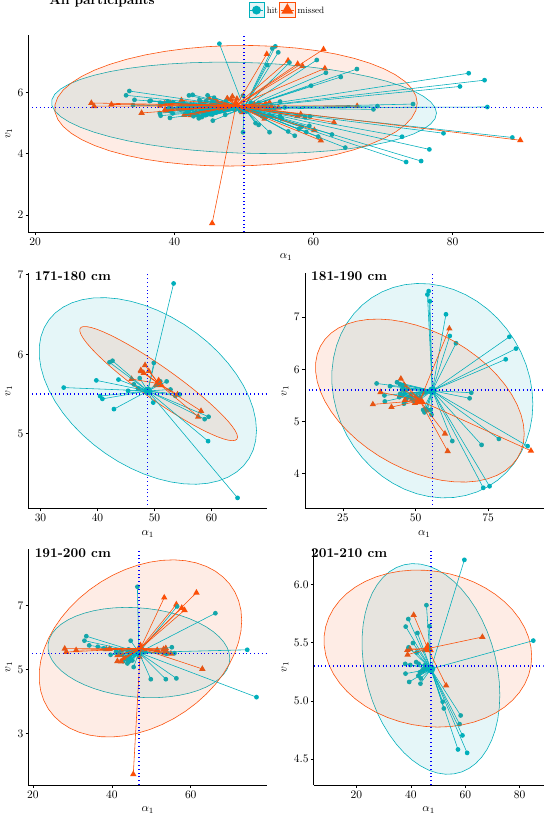
Figure 8. Relationships between α 1 and v 1